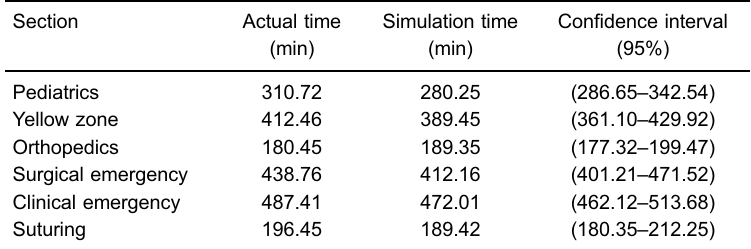
Table 1. Comparison of length of stay from the simulation model and the emergency department information system.